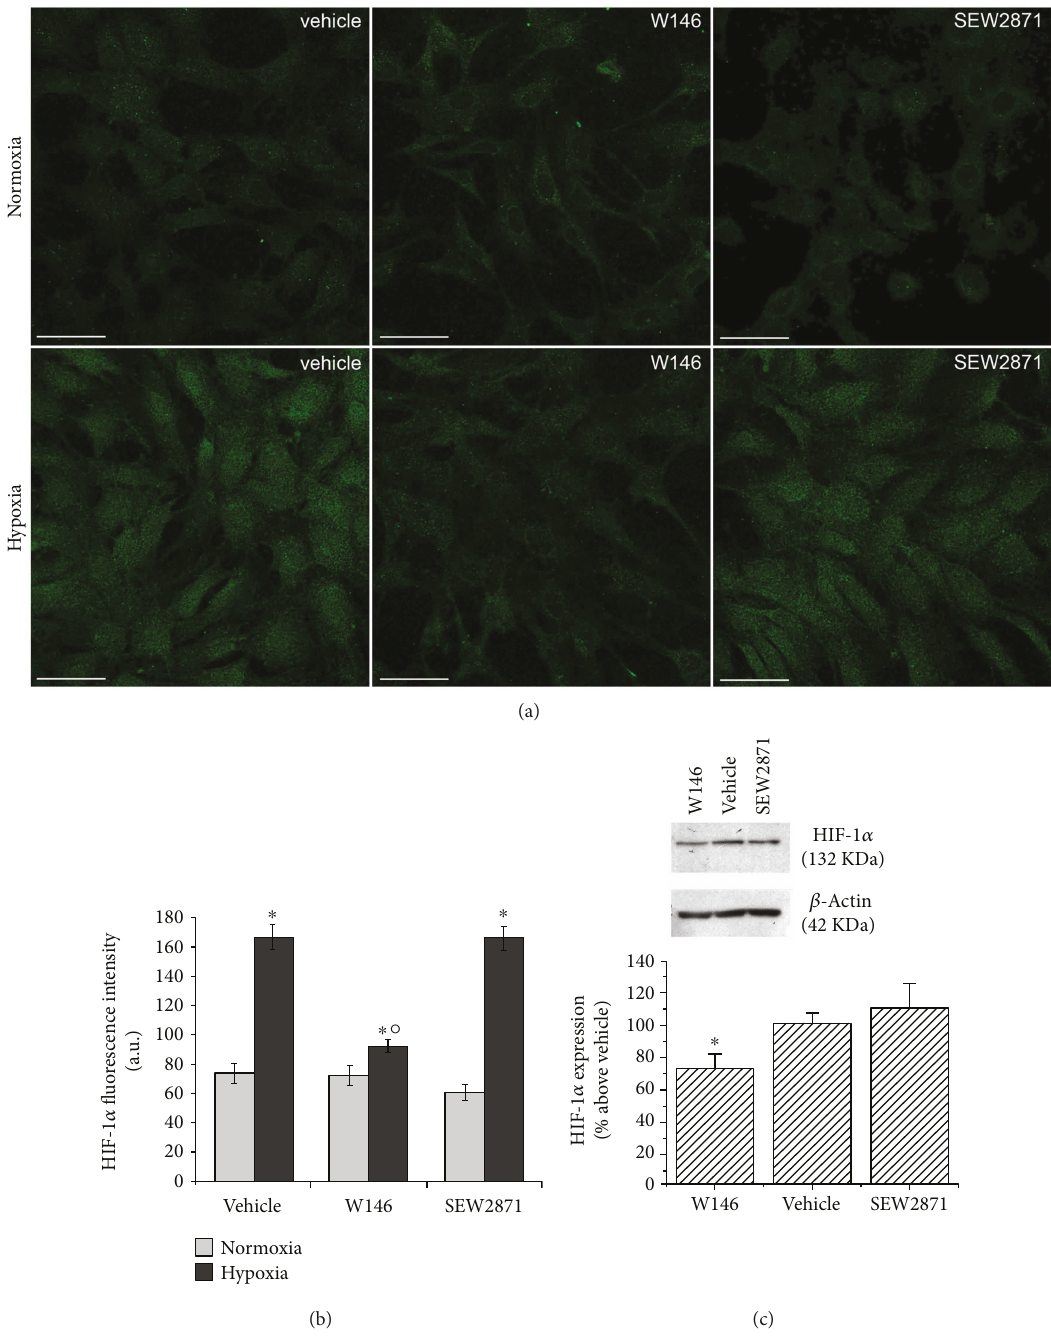
Figure 5: HIF-1 α expression. BM-MSCs were cultured for 48h in normoxic or in hypoxic conditions in the absence (vehicle) or in presence of 2 μ M S1PR1 receptor antagonist, W146, or 2 μ M S1PR1 receptor agonist, SEW2871. (a) Representative immuno fl uorescence confocal images of cells cultured on glass coverslips in the indicated experimental conditions, fi xed and immunostained with antibodies against HIF-1 α (green). Scale bar 50 μ m. The images are representative of at least three independent experiments with similar results. (b) Densitometric analysis of the intensity of the HIF-1 α fl uorescence signal performed on digitized images. Data are mean ± S.E.M. (c) Western blotting analysis of HIF-1 α . Cell lysate (30 μ g) obtained from BM-MSCs cultured in hypoxia and treated as reported above was loaded onto SDS-PAGE and protein immunodetected by a speci fi c antibody. β -Actin was used as loading control. Blot shown is representative of at least three independent experiments with similar results. Data resulting from densitometric analysis of at least three independent experiments is shown in the graph (mean ± S.E.M.). Signi fi cance of di ff erences in (b) (one-way ANOVA and Newman-Keuls multiple comparison test), ∗ p < 0 05 versus normoxia, ° p < 0 05 versus vehicle hypoxia; in (c) (Student ’ s t -test), ∗ p < 0 05 versus